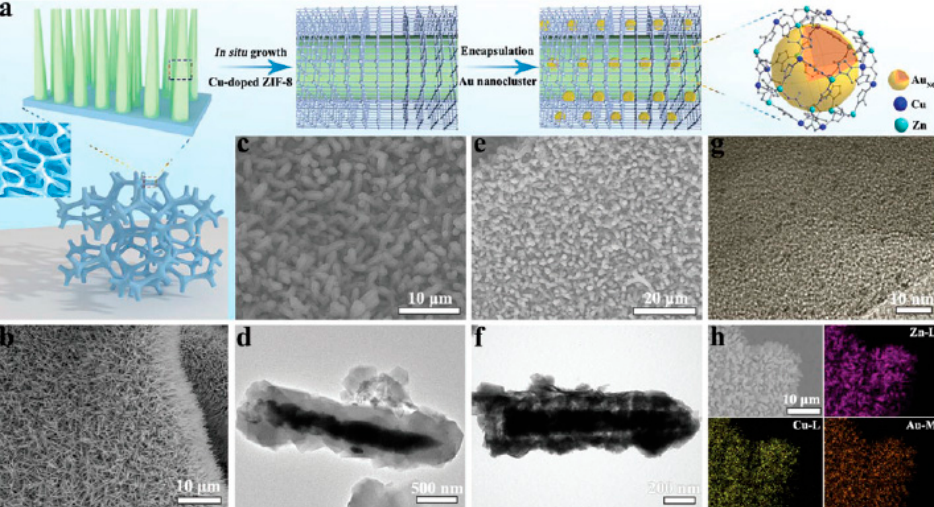
Figure 6. ( a ) Schematic diagram illustrating the synthetic procedures of the catalyst samples. ( b ) The SEM image of ZnO NRs. ( c ) The SEM image of ZIF-8(Cu) nanorod arrays (NRAs). ( d ) The TEM image of ZIF-8(Cu) NRAs. ( e ) The SEM image of AuNC@ZIF-8(Cu) NRAs (NC: nanoclusters). ( f ) The TEM image of AuNC@ZIF-8(Cu) NRAs. ( g ) The HRTEM image of AuNC@ZIF-8(Cu) NRAs. ( h ) The element mapping of Zn, Cu and Au of AuNC@ZIF-8(Cu) NRAs. Reproduced with permission from [57].